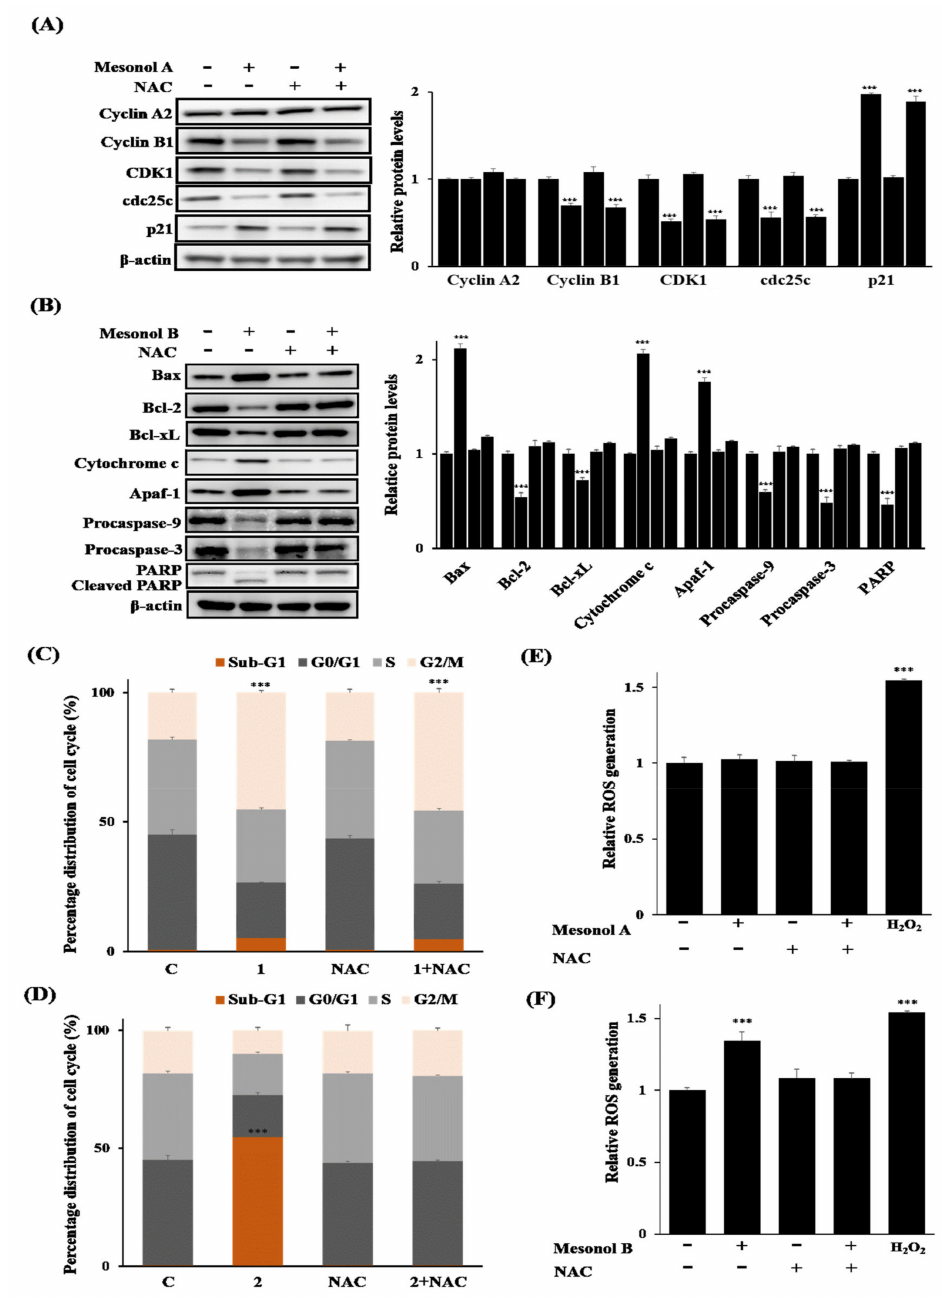
Figure 5. Differential effects of mesonols A ( 1 ) and B ( 2 ) on cell cycle arrest and apoptosis and the involvement of ROS. ( A ) Western blot analysis of cyclin A2, cyclin B1, CDK1, cdc25c, and p21 in U937 cells treated with 5 µ M mesonol A for 12 h with or without pretreatment with 10 mM NAC for 1 h. Relative protein levels were quantified by normalization to the β -actin levels. ( B ) Western blot analysis of Bax, Bcl-2, Bcl-xL, cytochrome c, Apaf-1, procaspase-9, procaspase-3, and PARP in U937 cells treated with 10 µ M mesonol B for 6 h with or without pretreatment with 10 mM NAC for 1 h. Relative protein levels were quantified by normalization to the β -actin levels. U937 cells were pretreated with or without 10 mM NAC for 1 h, followed by ( C ) 5 µ M mesonol A for 12 h or ( D ) 10 µ M mesonol B for 6 h, and the cell cycle distribution was analyzed by flow cytometry after PI staining. ( E , F ) U937 cells were treated with 5 µ M mesonol A or 10 µ M mesonol B for 30 min with or without pretreatment with 10 mM NAC for 1 h. H 2 O 2 (100 µ M) was used as a positive control. Intracellular ROS levels were measured by DCFH-DA, and DCF fluorescence was examined with a fluorescence plate reader as described in the Materials and methods. The values presented are the means ± SD ( n = 3). Values with different letters indicating significant differences, as determined by Dunnett’s method. *** p < 0.001 relative to the control